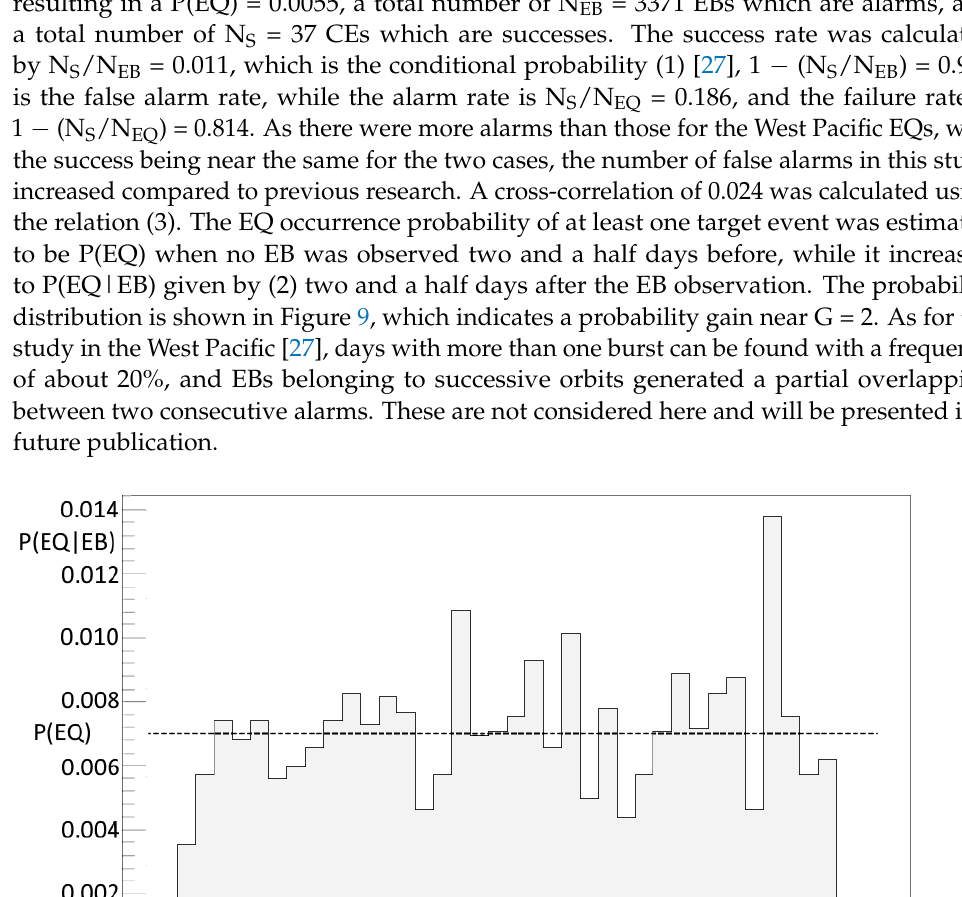
Figure 10. The probability gain approaching the correlation peak around 57 h; it was obtained by fitting the probability gain distribution from bin intervals of 1.5, 2, 2.5, 3, 4, 5, 6, 7, 8, 9, 10, 12, 14, and 17 h; the 3 sigmas limit is indicated by the red horizontal dashed.